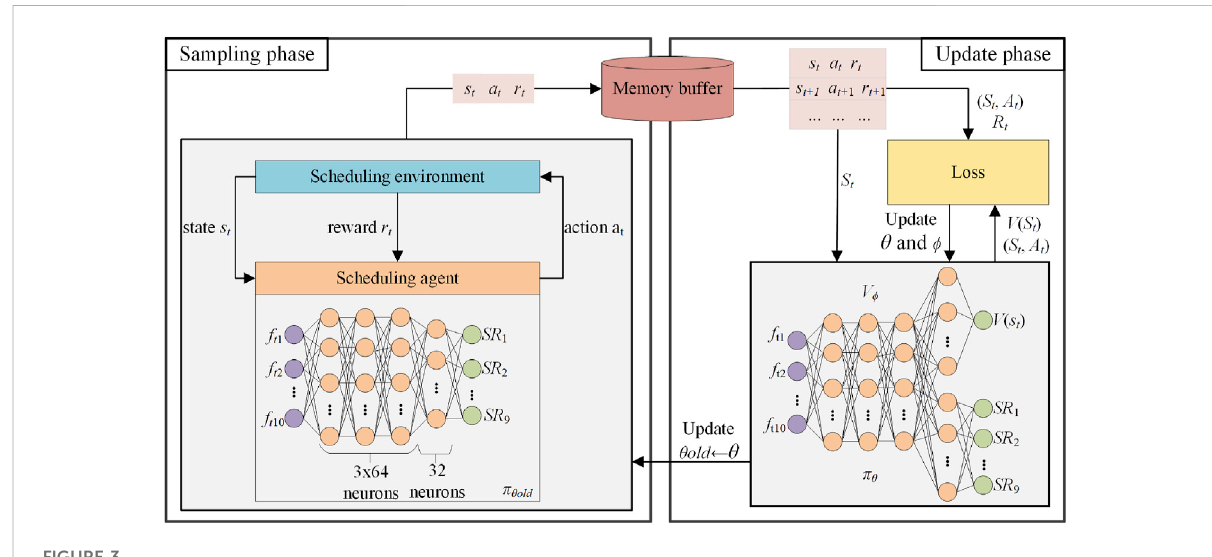
FIGURE 3 PPO-based DRL training process for